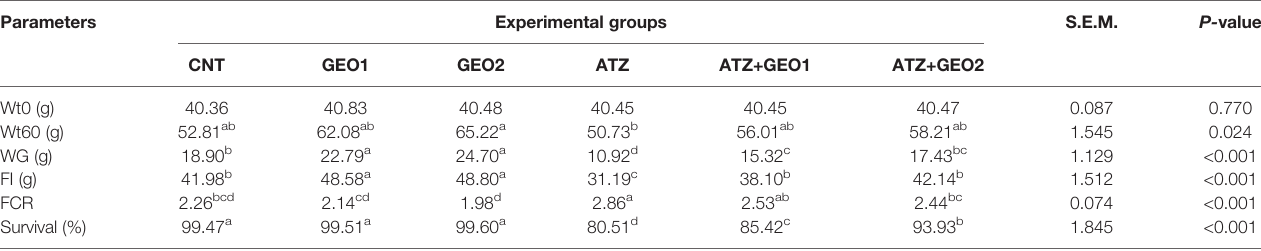
TABLE 2 | Growth parameters, feed utilization parameters, and survival rates of Nile tilapia in response to sub-lethal atrazine (ATZ) exposure and/or dietary supplementation with Panax ginseng essential oil (GEO) for 60 days. Parameters Experimental groups